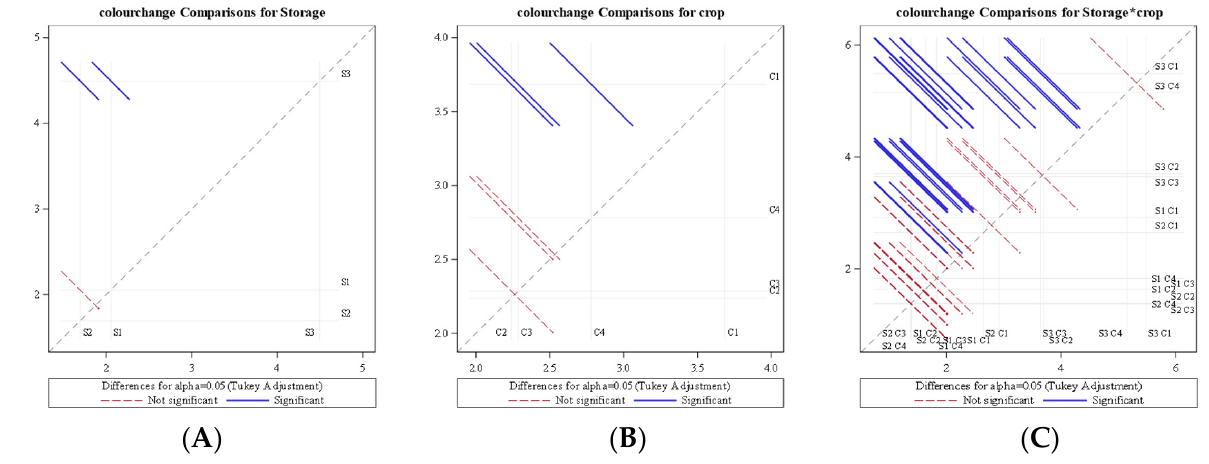
Figure 11. Diffogram showing the effect of storage condition and crop on average daily colour change. ( A ) Colour change comparison for storage ( B ) Colour change comparison for crop ( C ) Colour change comparison for storage*crop S1—LCTR; S2—VCR; S3—ambient storage; C1—bitter gourd; C2—okra; C3—mango;